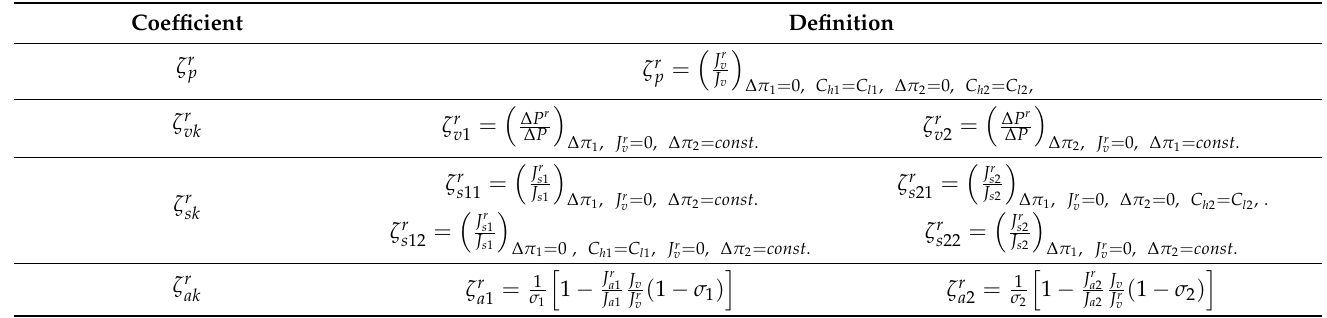
Table A2. Physical interpretation of concentration polarization